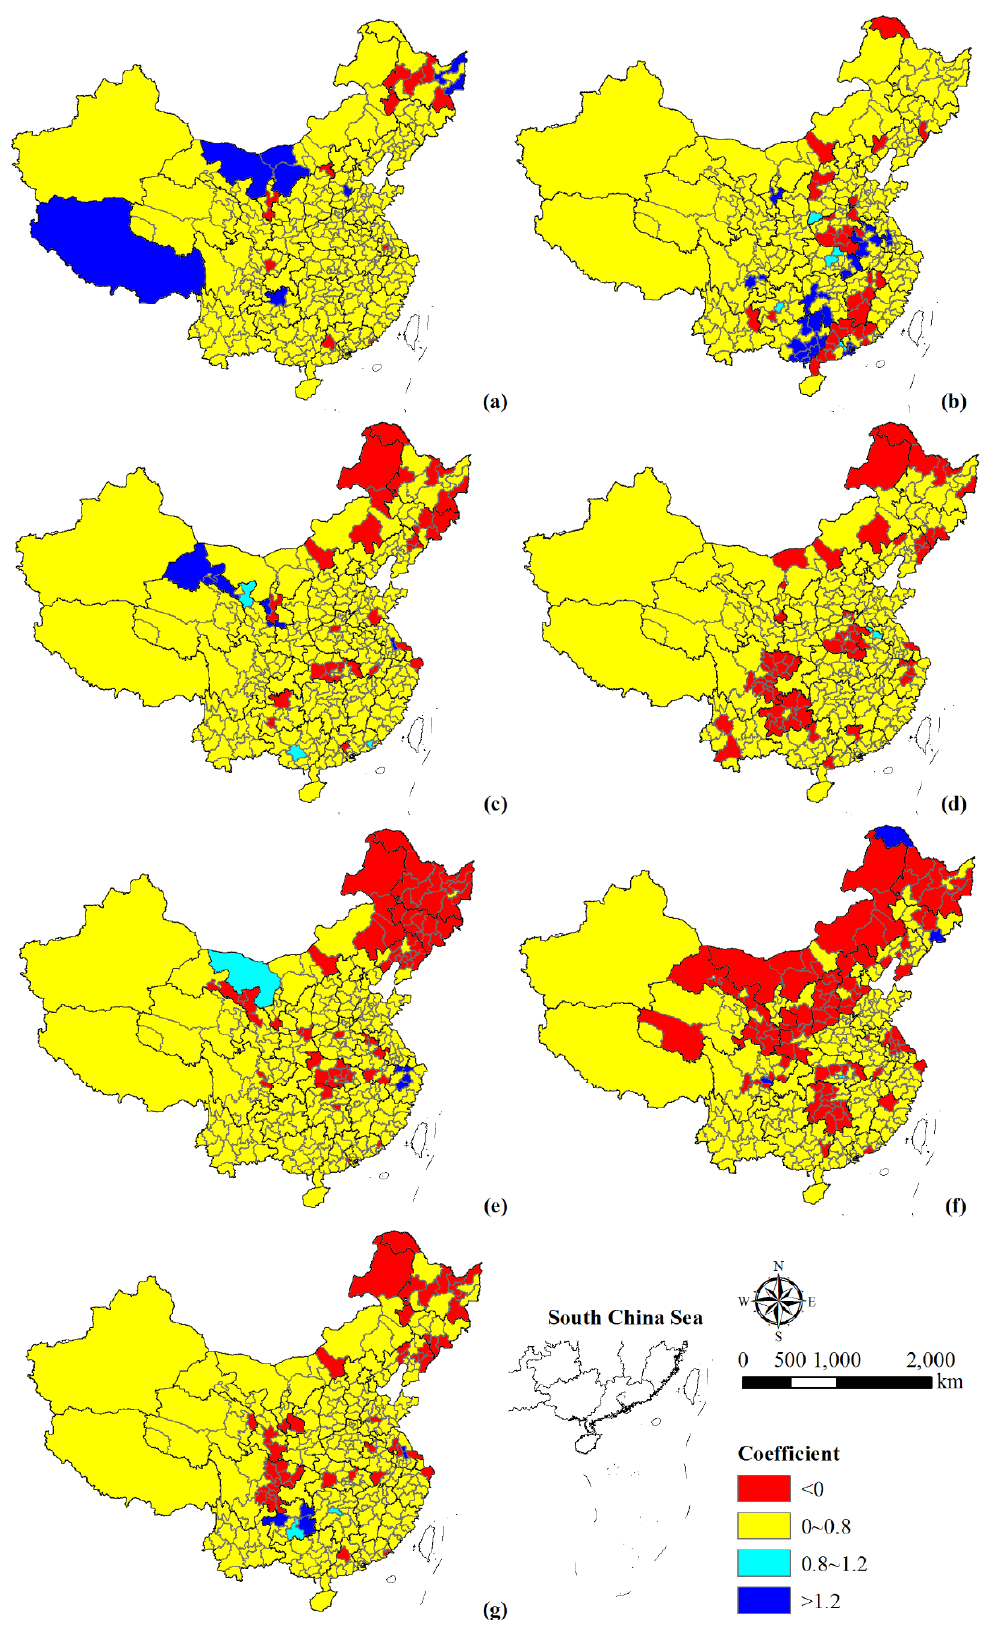
Figure 5. Spatial variation of the elasticity coefficient between population and GDP during 1990–1995 ( a ), 1995–2000 ( b ), 2000–2005 ( c ), 2005–2010 ( d ), 2010–2015 ( e ), 2015–2018 ( f ), and 1990–2018 ( g ).